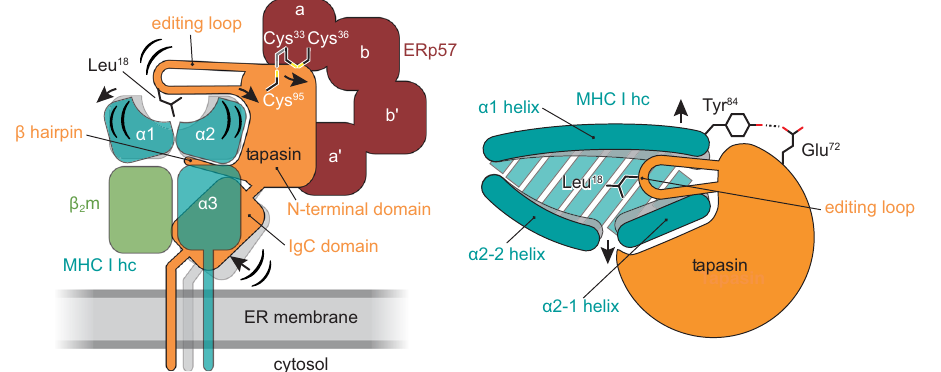
dotted line indicates a polar interaction between tapasin (Glu 72 ) and chaperoned MHCI(Tyr 84 oftheheavychain,hc).Forreasonsofclarity,ERp57(red)isnotshown in the right